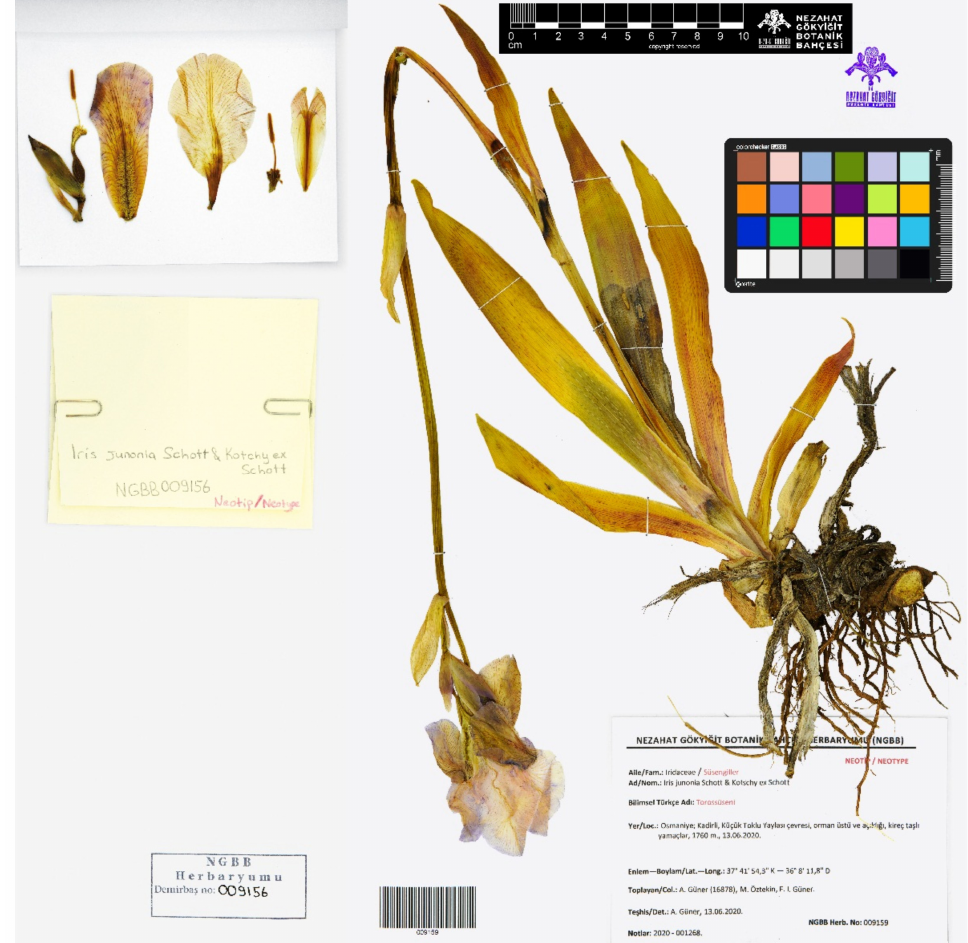
Figure 3. Neotype of Iris junonia (NGBB009159), by permission of the